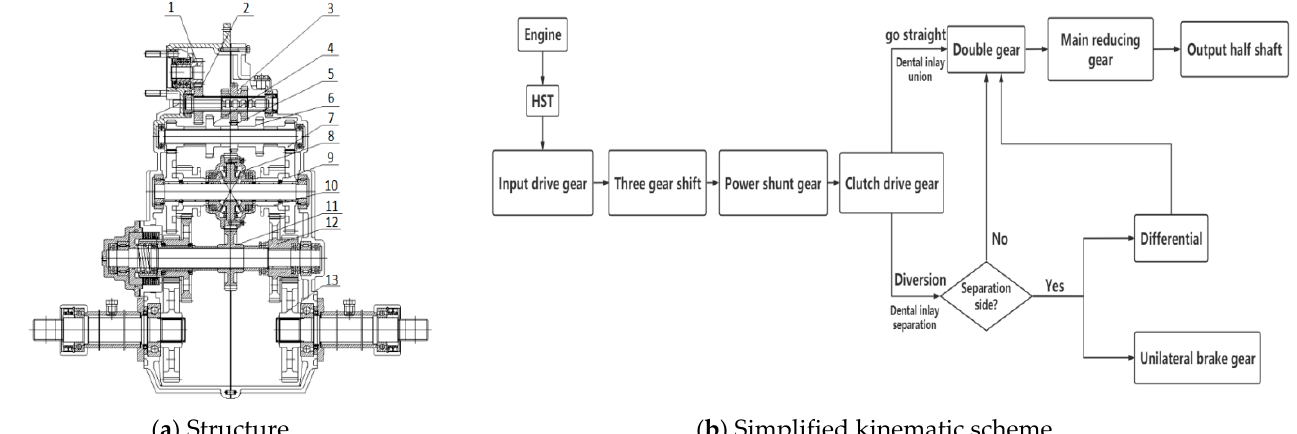
Figure 1. Diagram of differential inverse gearbox: 1 — Input driving gear; 2 — Input driven gear; 3 — Shift transmission gear (first gear, third gear, second gear from left to right); 4 — First driven gear; 5 — Third driven gear; 6 — Second driven gear; 7 — Power shunt gear; 8 — Clutch driving gear; 9 —